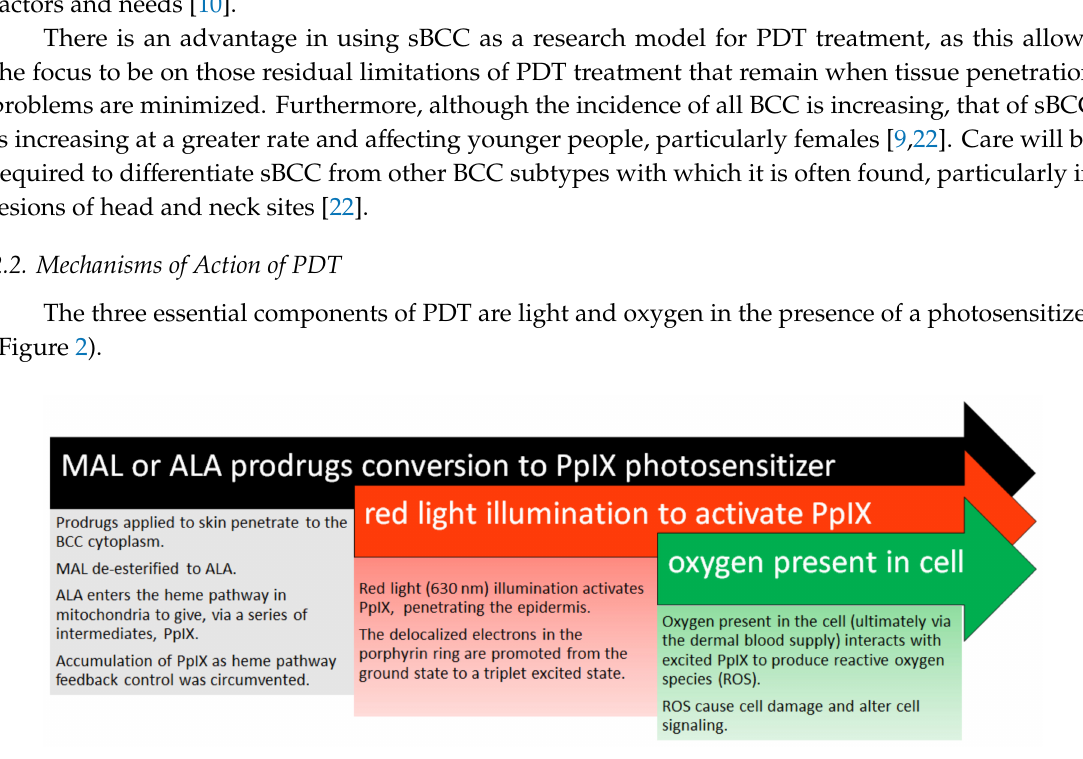
Figure 2. Topical photodynamic therapy mechanisms of action (MAL, methyl aminolevulinate; ALA, aminolevulinic acid; PpIX, protoporphyrin IX; BCC, basal cell carcinoma; and ROS, reactive oxygen